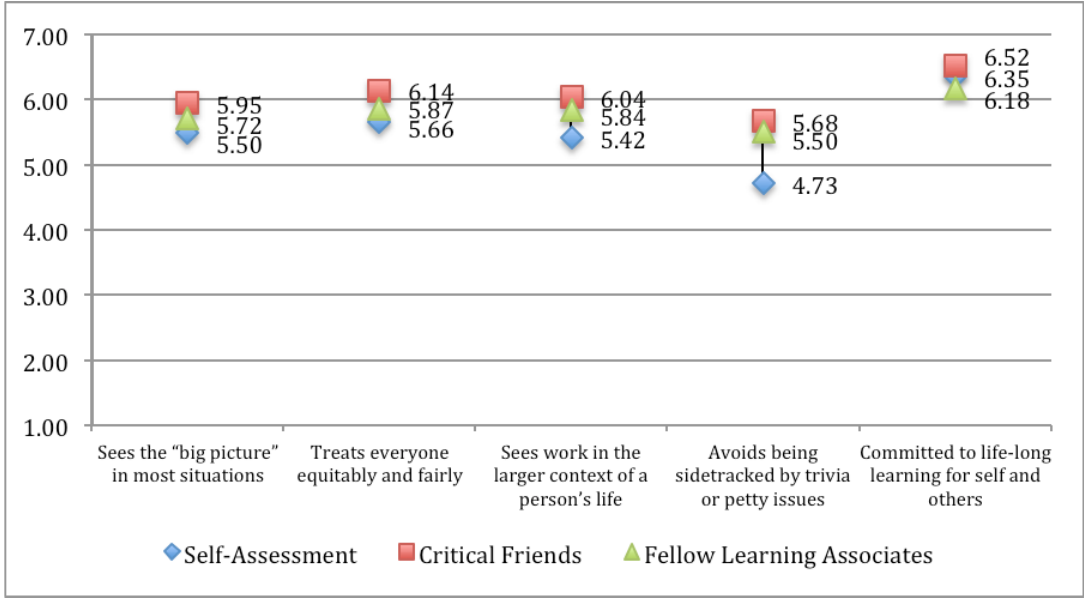
Figure 6. Perceptions of Purpose. Self-Assessment N=74, Critical Friends N=573, Fellow Learning Associates N=74.